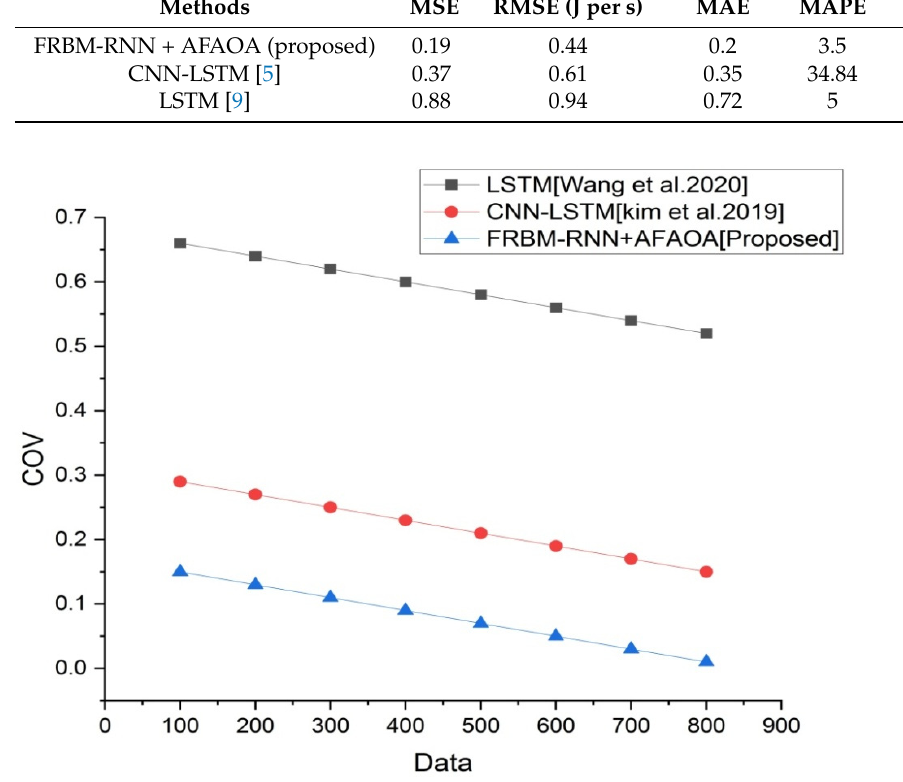
Figure 9. Graphical analysis of various methods depending on COV [Source: Author].